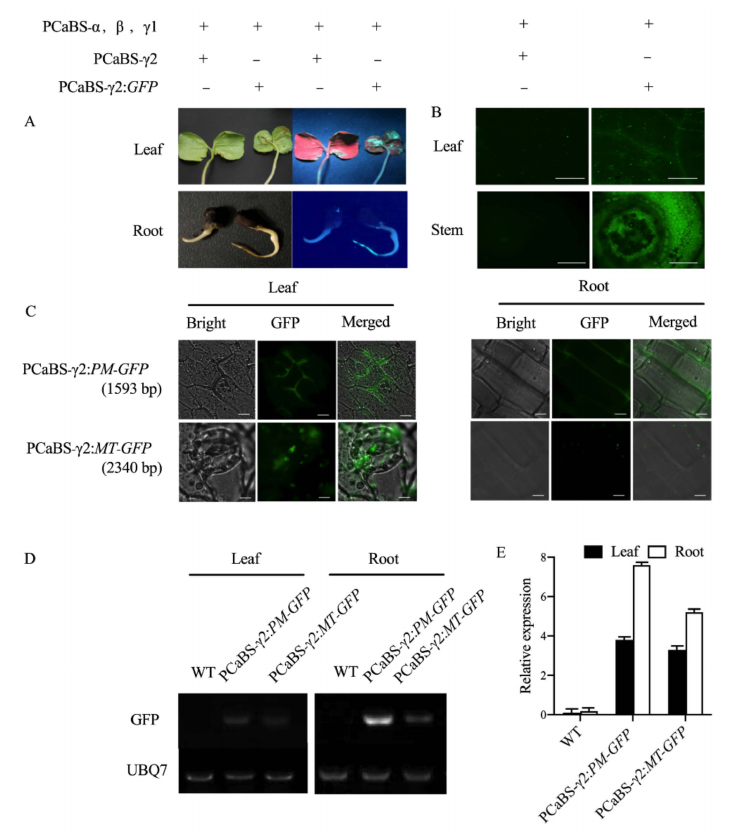
Figure 1. Four-component BSMV system infected cotton via seed immersion and expressed large segments of genes. ( A ). Seed immersion delivery of the BSMV- γ 2: GFP system infected cotton